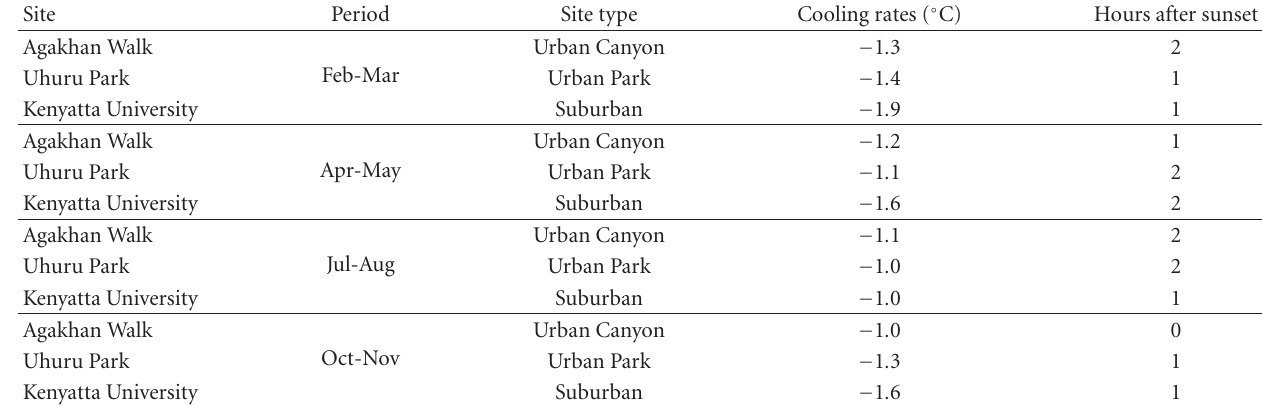
Table 1: Highest cooling rates ( ◦ C/hr) after sunset for three sites in Nairobi city.